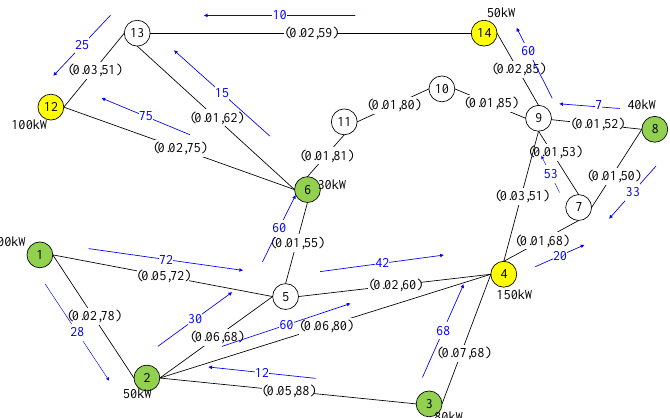
Figure 10. Path selection and source-load matching performed by GRASP on the IEEE14